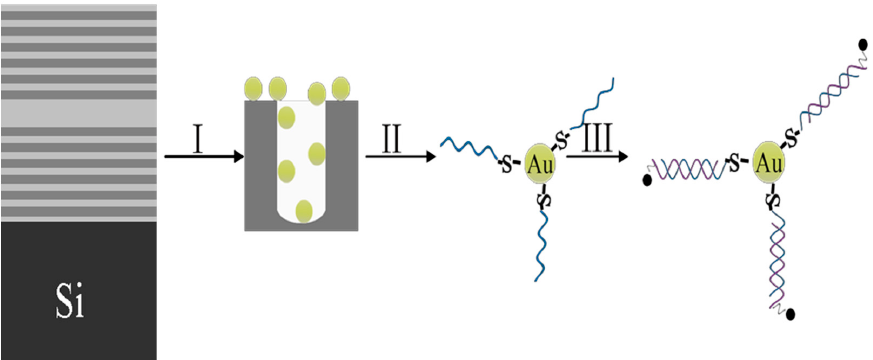
Figure 1. The flow-process diagram of DNA detection on metal NPs /PSiMC device. (I) Au NPs adsorbed on functionalized PSiMC; (II) the immobilization of target DNA on Au NPs /PSiMC device substrate; (III) the hybridization of probe RRA-DNA sequences with target DNA.